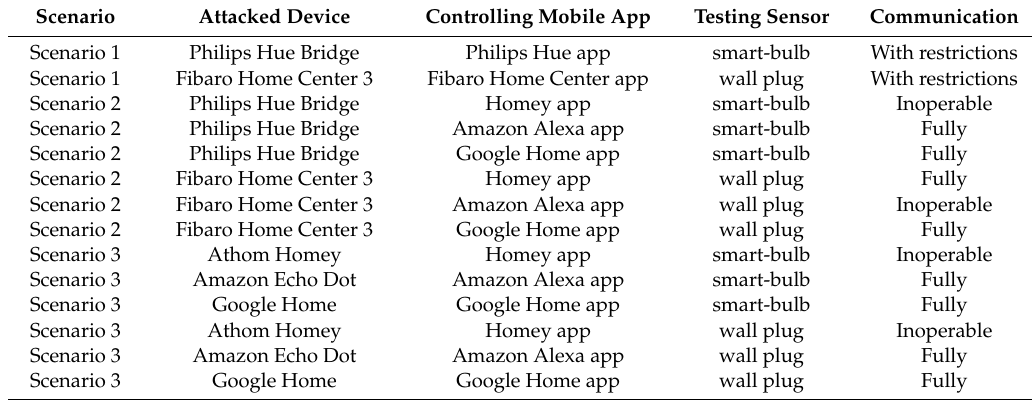
Table 3. A brief overview of the scenarios used during the experimental